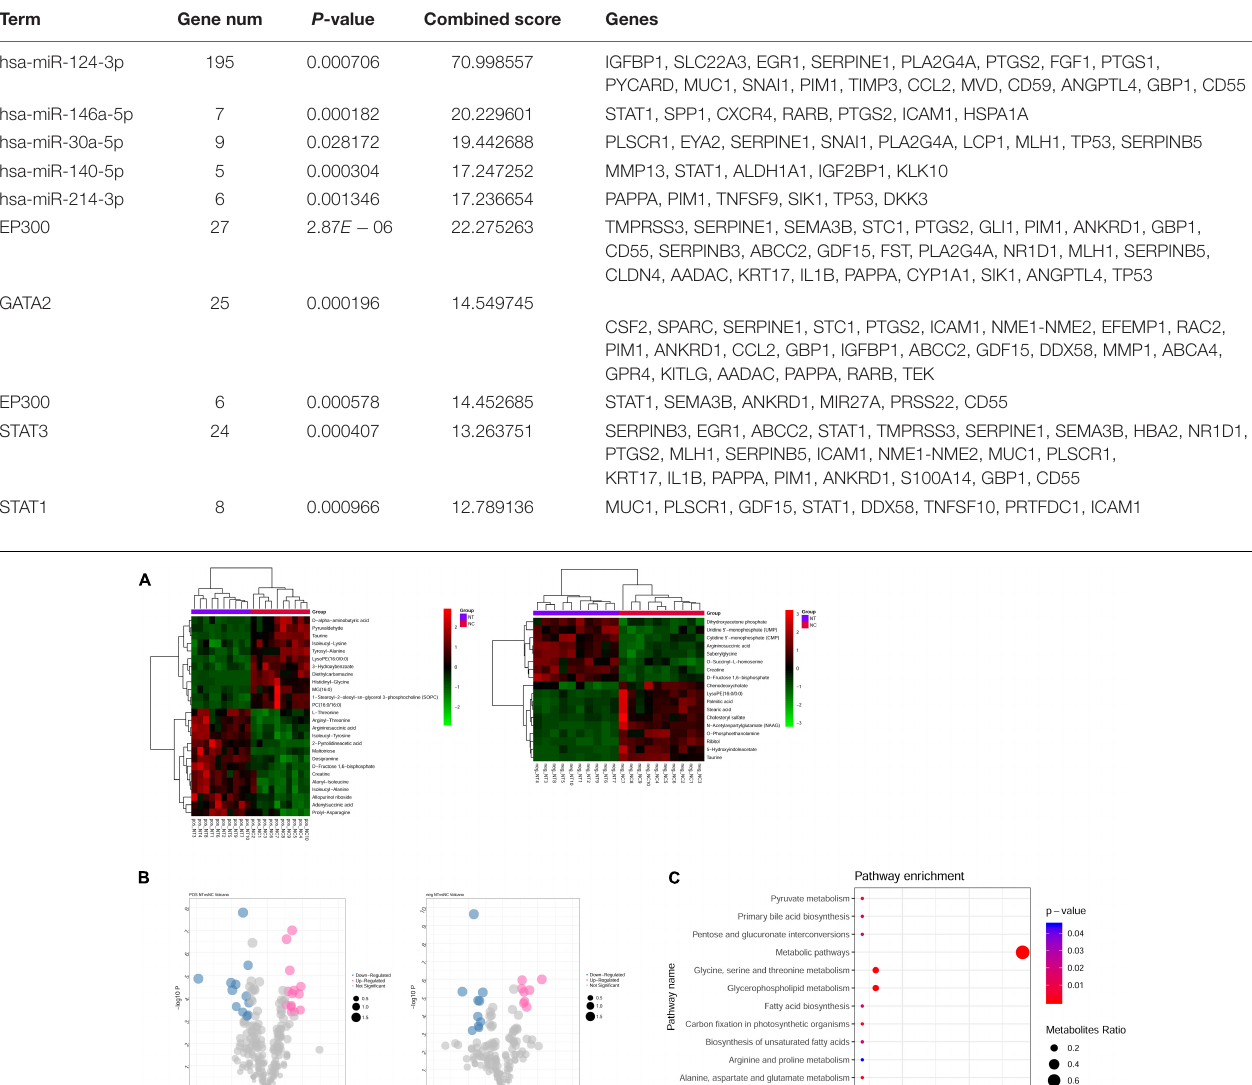
TABLE 2 | The top five miRNAs and transcription factors with higher combined scores were predicted to be crucial factors associated with ovarian cancer.